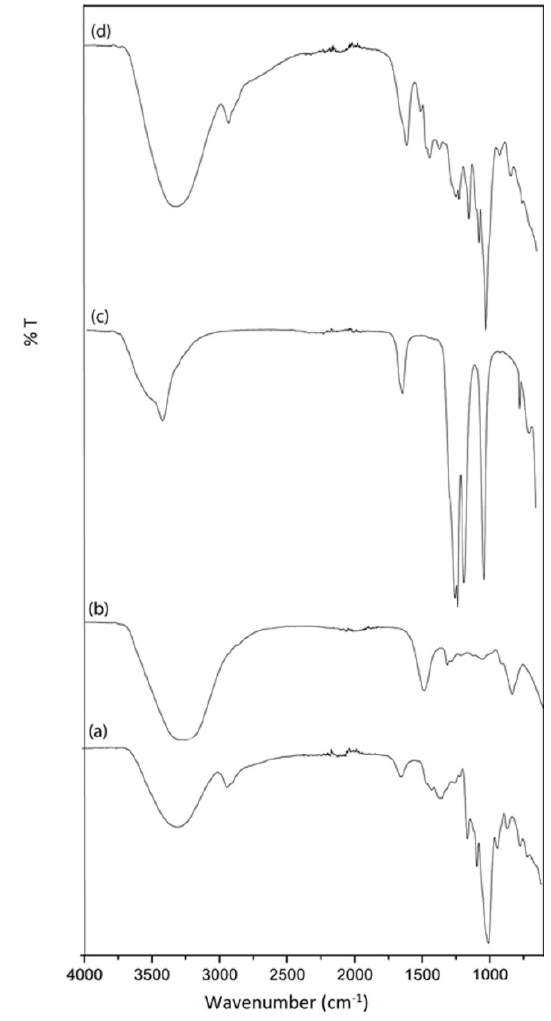
Figure 3. FTIR spectra of the pure constituents: ( a ) starch film, ( b ) RF resin, ( c ) lithium triflate, and ( d ) typical starch/RF/LiTf sample.